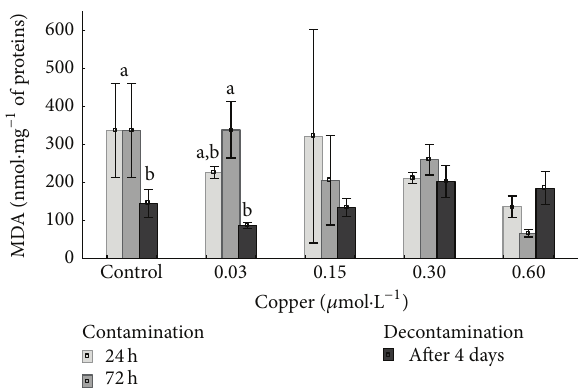
Figure 6: Mean levels of MDA at 24 h, at 72 h, and after 4 days in the gills of the mussel Perna perna under copper exposure . In each group, the means with different letters have significant differences ( 𝑃 < 0.05